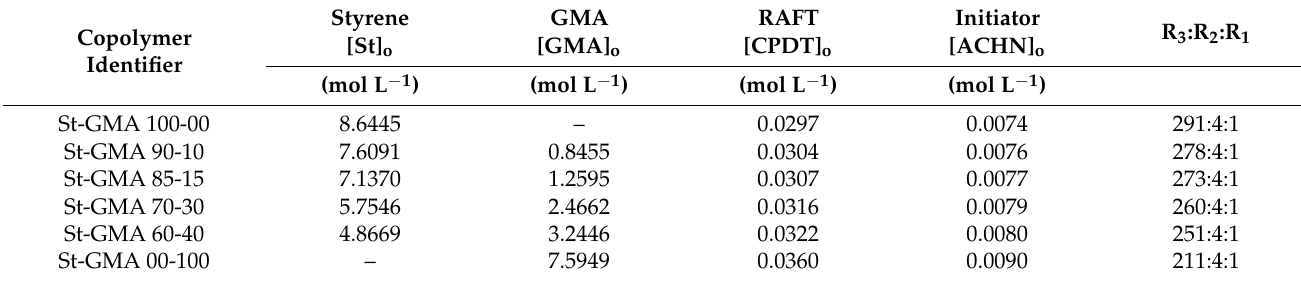
Figure 2. Simplified polymerization scheme. Table 8. Summary of experimental conditions used in this study; T = 103 ◦ C; [St + GMA] o :[CPDT] o